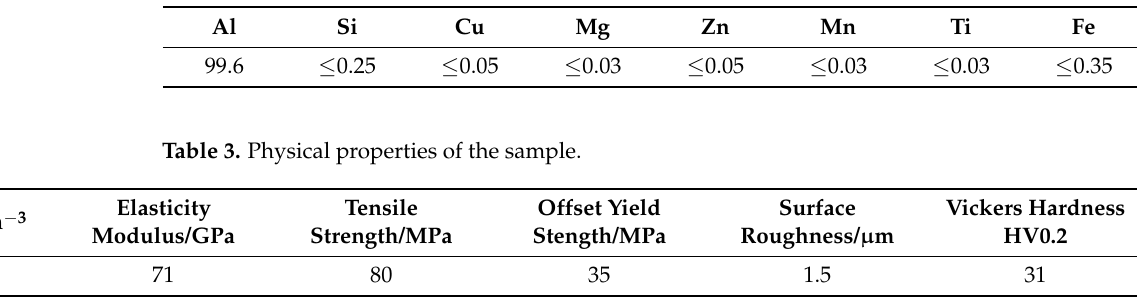
Table 2. Chemical composition of the sample (mass%).